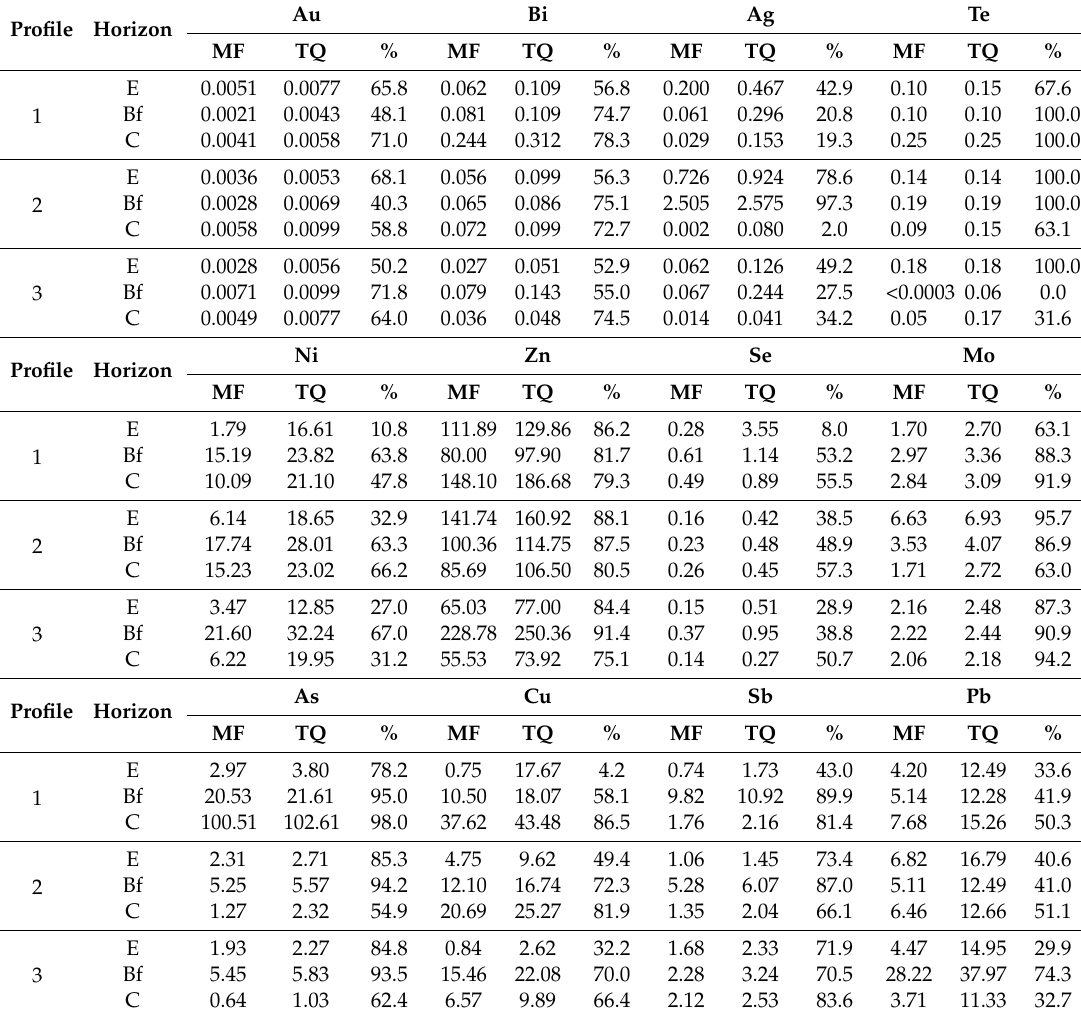
Table 7. Percentages of mobile forms of elements in surface sediments in the Novye Peski area. MF—mobile form (ppm); TQ—total quantity (sum of element concentration in all extracts, ppm); %—mobile form percentage from the total